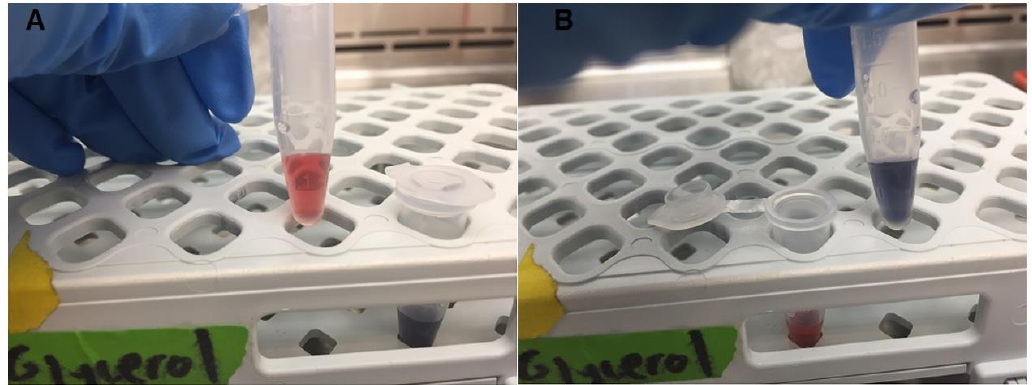
Figure 7. Validation of our water quality detection device prototype. ( A ) Eppendorf tube containing the DNA probes, lysozyme, and gold nanoparticles with no bacteria present. ( B ) Eppendorf tube containing the DNA probes, lysozyme, and gold nanoparticles with E. coli present (concentration: 10 8 cells/mL). The change in color from ( A ) (red) to ( B ) (blue) is visually identifiable.